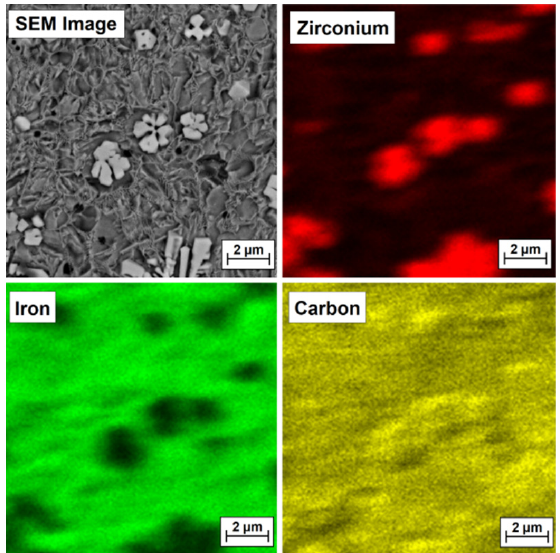
Figure 11. Microstructure and EDS mapping of Fe/ZrC coating produced using a laser beam power of 700 W—middle area of melted zone .